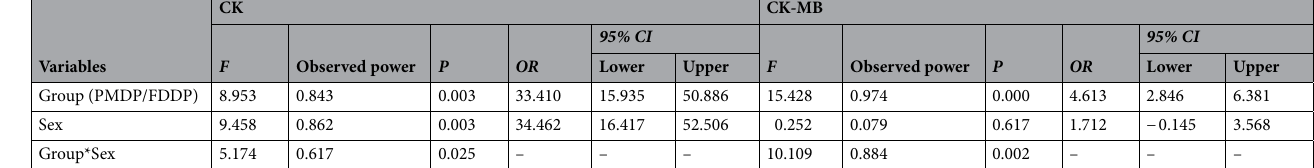
Table 5. Multivariate covariance analysis of factors related to elevated CK and CK-MB. The baseline level of CK or CK-MB was taken as a covariate.